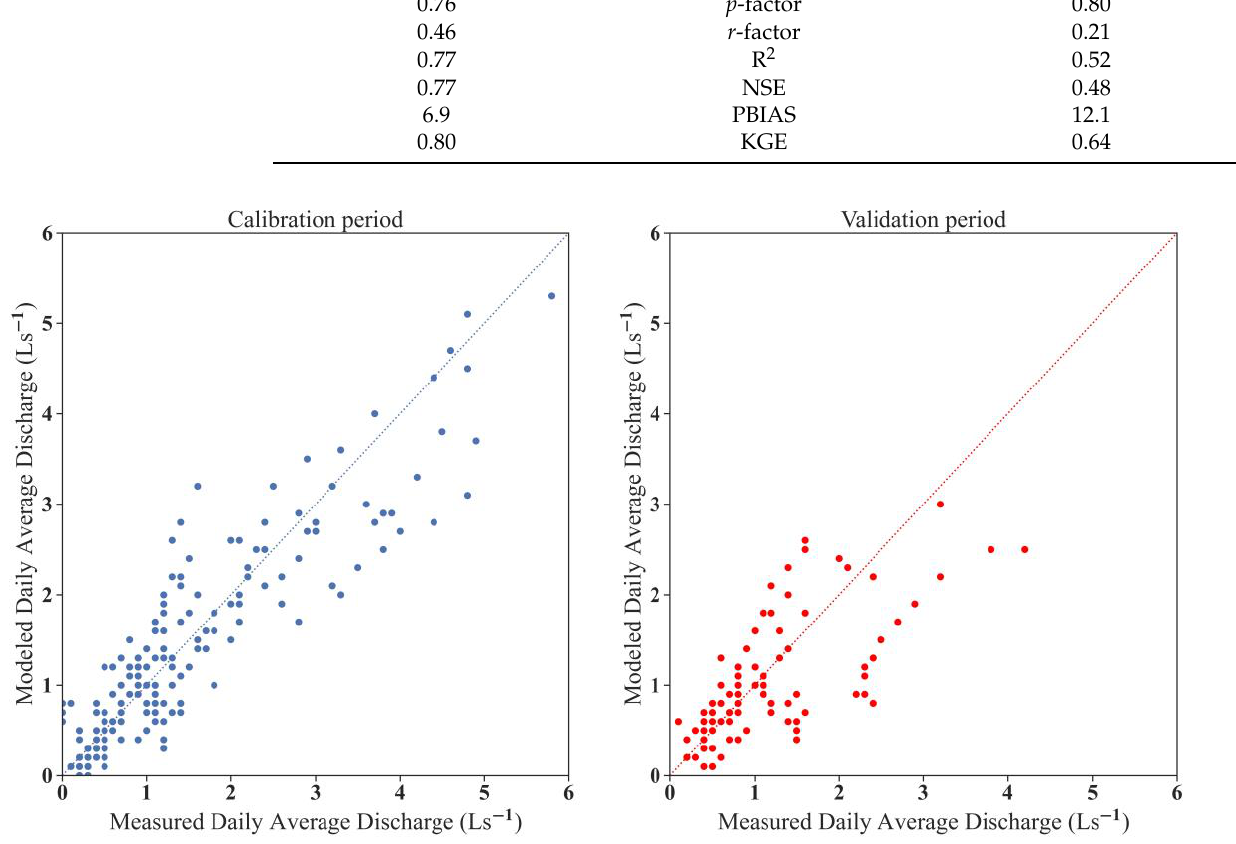
Figure 4. Correlation of modeled and observed discharge values at Nuˇcice’s outlet during the calibration and validation periods; a 1:1 line is included for